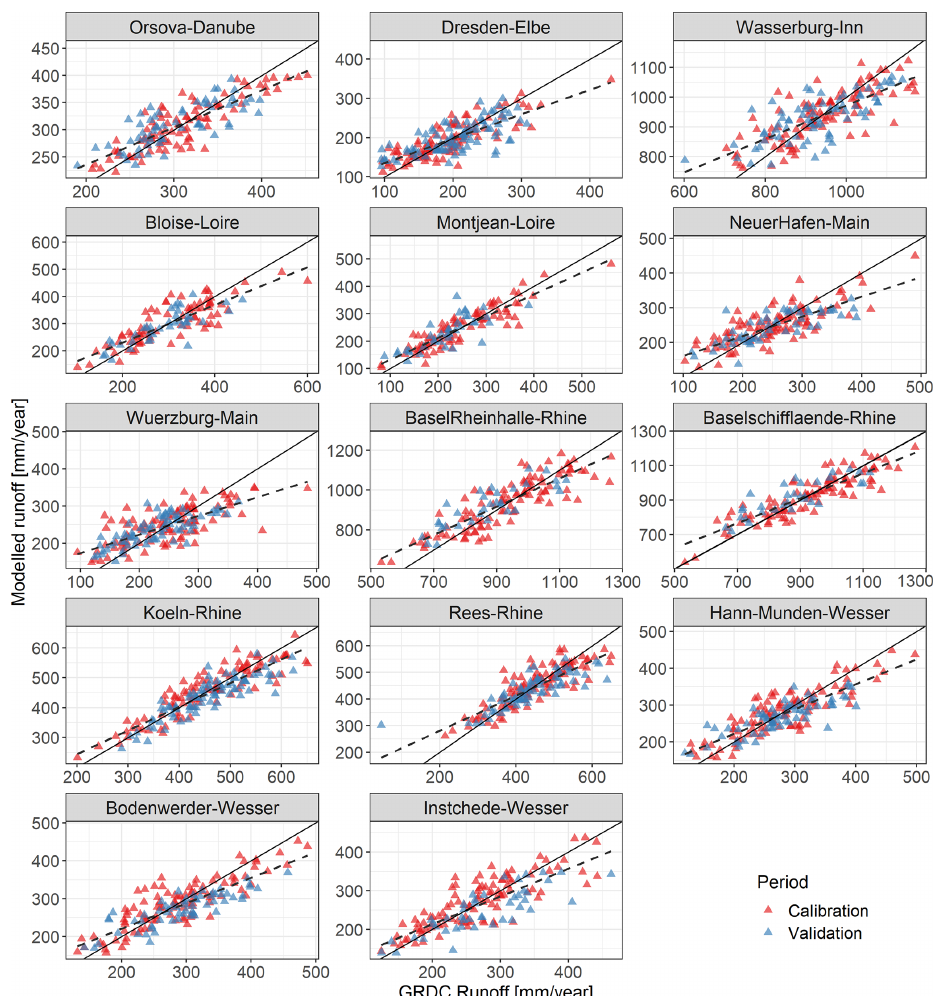
Figure 9. Observed and simulated runoff for 14 selected catchments in the calibration and validation periods. The solid line represents the 1 : 1 relation, and the dashed line corresponds to fitted regression between observed and simulated